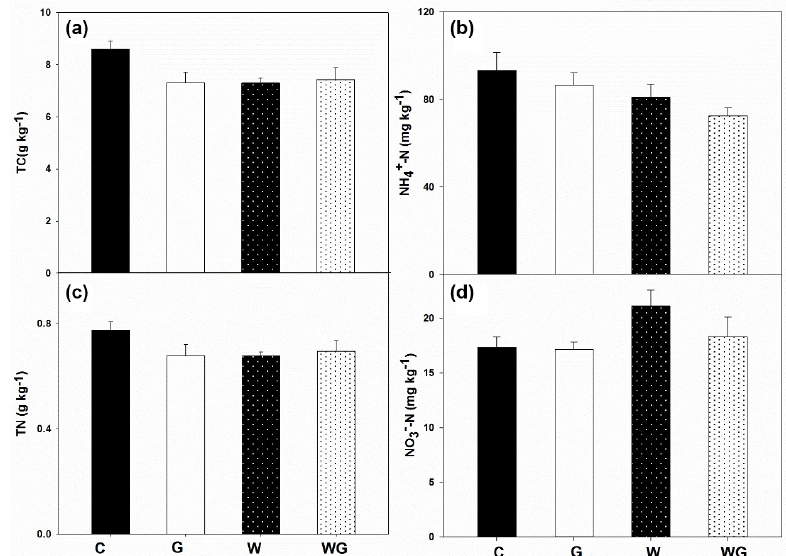
Figure 2. Soil total carbon (TC) (a) , soil total nitrogen (TN) (b) , soil NH + bar), control treatment; G (white bar), winter grazing treatment; W (white-dotted bar), warming treatment; WG (black-dotted bar), warming combined with the winter grazing treatment. Values are means ± 1s.e.m. ( n = 4).